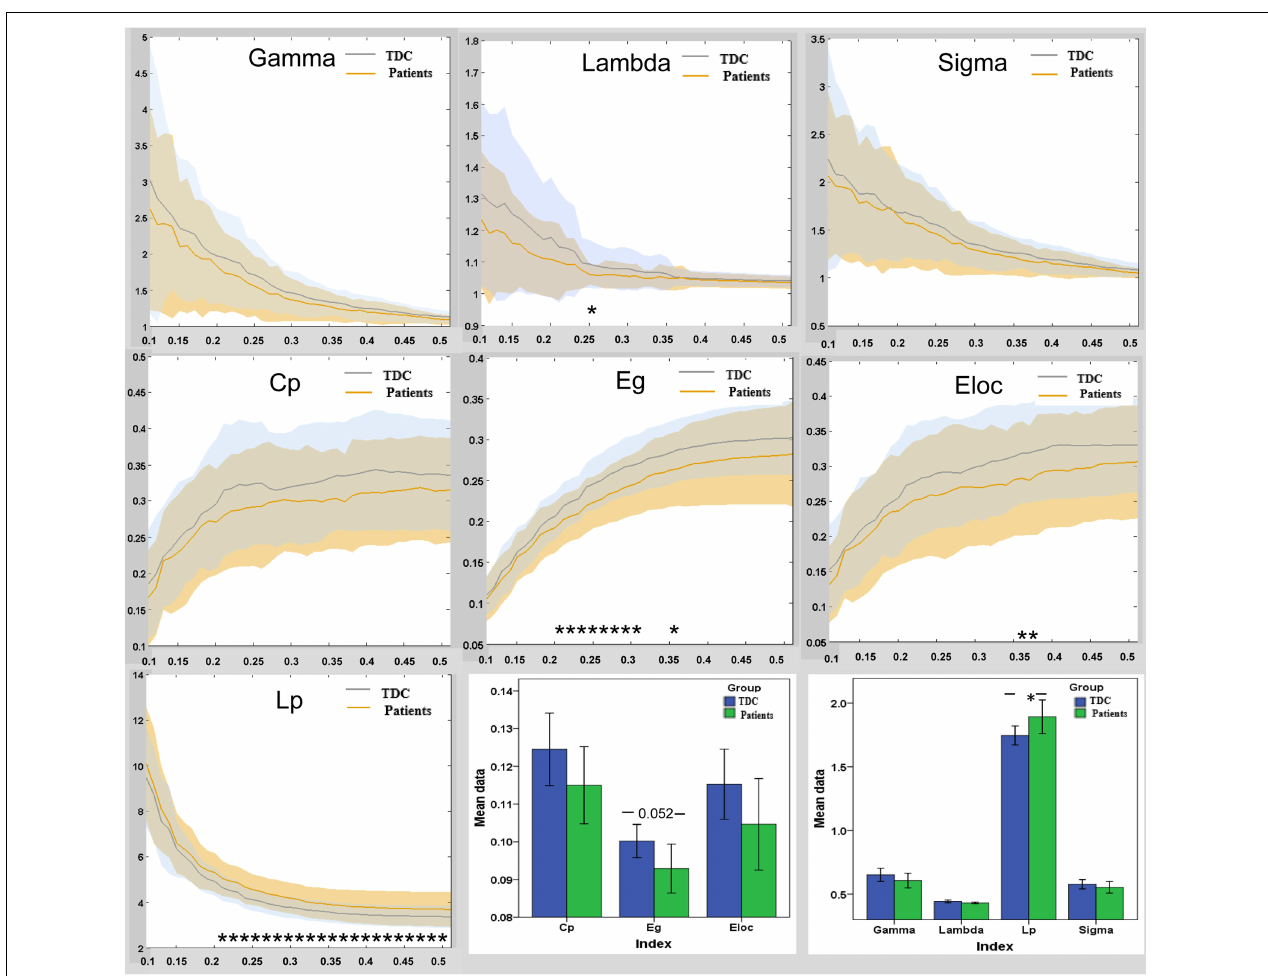
FIGURE 2 | Group differences in global functional properties of brain topology in DMN between the patient and TDC. In the range of sparsity (0.1 ∼ 0.5), the functional networks of DMN in both groups exhibited a small-world property. Bar plots of the global efficiency, local efficiency, clustering co-efficiency, gamma, lambda, L p , and sigma for the children with GTCS and TDC. Asterisks (*) indicate a significant difference between the two groups. E g , global efficiency; E loc , local efficiency; C p , clustering coefficient; L p , characteristic path length; TDC, typically developing children. TABLE 3 | Default-mode network (DMN) regions showing disrupted nodal topologic properties in children with GTCS compared with the controls. Regions Cluster coefficient ( t / p ) Nodal efficiency ( t / p ) Nodal local efficiency ( t / p ) Degree centrality ( t / p ) Betweenness centrality ( t / p ) L TPJ 2.29/0.026